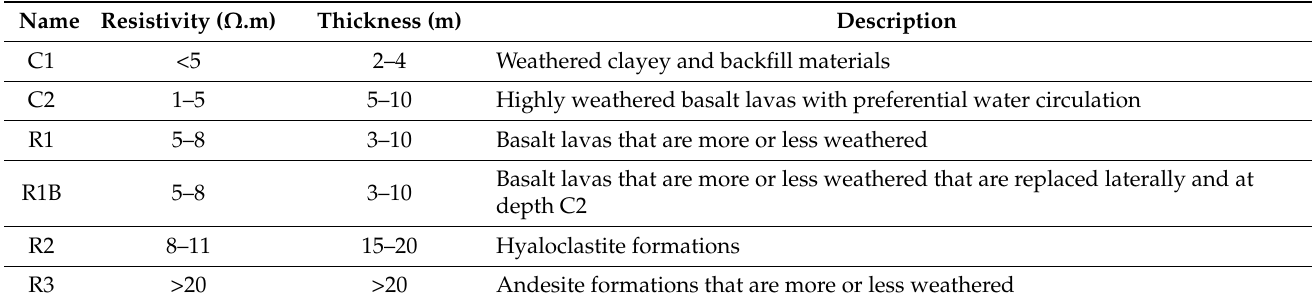
Table 4. Characteristics of the different formations observed in the la Morne-Figue area.